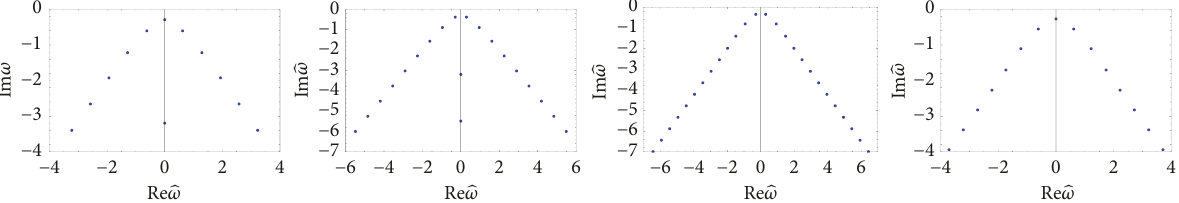
Figure 23: QNMs (blue spots) of the gauge mode for |𝛾 2 | = 1/24 (the first two panels are for 𝛾 2 = −1/24 and the second two panels for 𝛾 = 1/24 ) and ̂𝛼 = 0 . The first and third panels are the QNMs of the gauge mode and the second and forth panels are that of the dual gauge 2 mode.